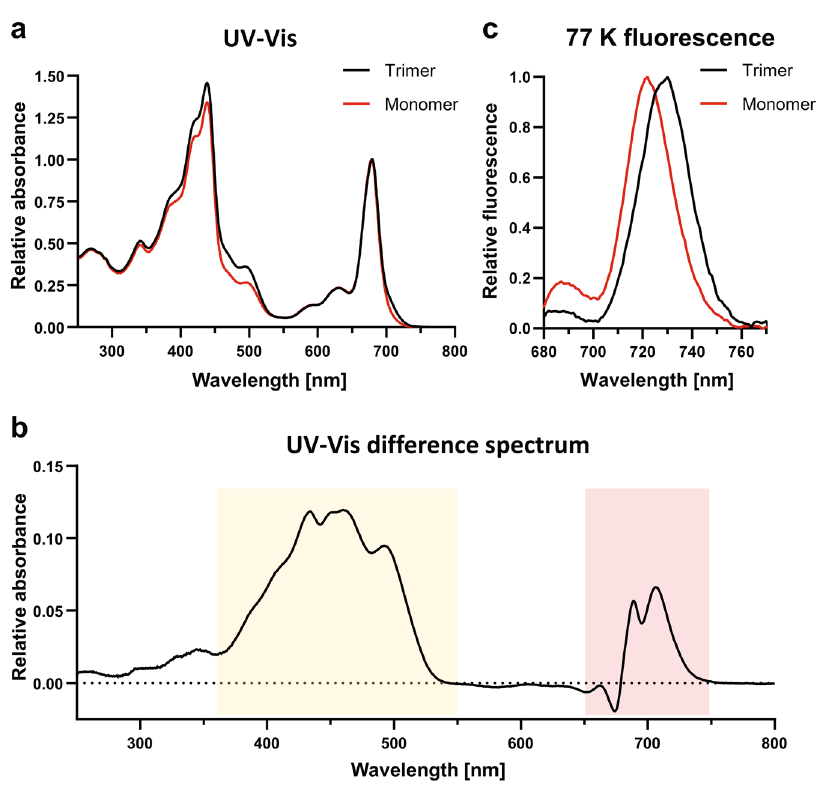
Fig. 2 UV-Vis and 77 K spectra of trimeric and monomeric PSI from T. elongatus . a UV-Vis spectra. GraDeR 43 -prepared samples were diluted in buffer B + 0.005% (w/v) GDN. b UV-Vis difference spectra (trimer – monomer) were calculated after normalization at the chlorophyll a peak (678 nm). Differences related to the absorption of carotenoids (orange) and red chlorophylls (red) are indicated by the colored background. c 77 K fl uorescence spectra. Samples were diluted in buffer B + 0.03% (w/v) β -DDM. Measurements were carried out at an excitation wavelength of 436 nm with a step size of 1 nm and a bandpass fi lter of 5